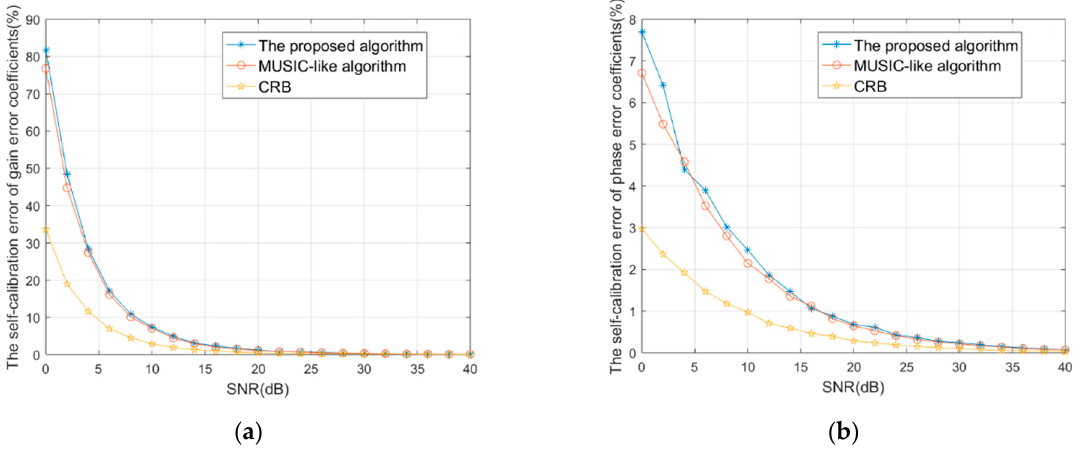
Figure 4. The self-calibration errors versus SNR. ( a ) Δ g versus SNR; ( b ) Δφ versus SNR.